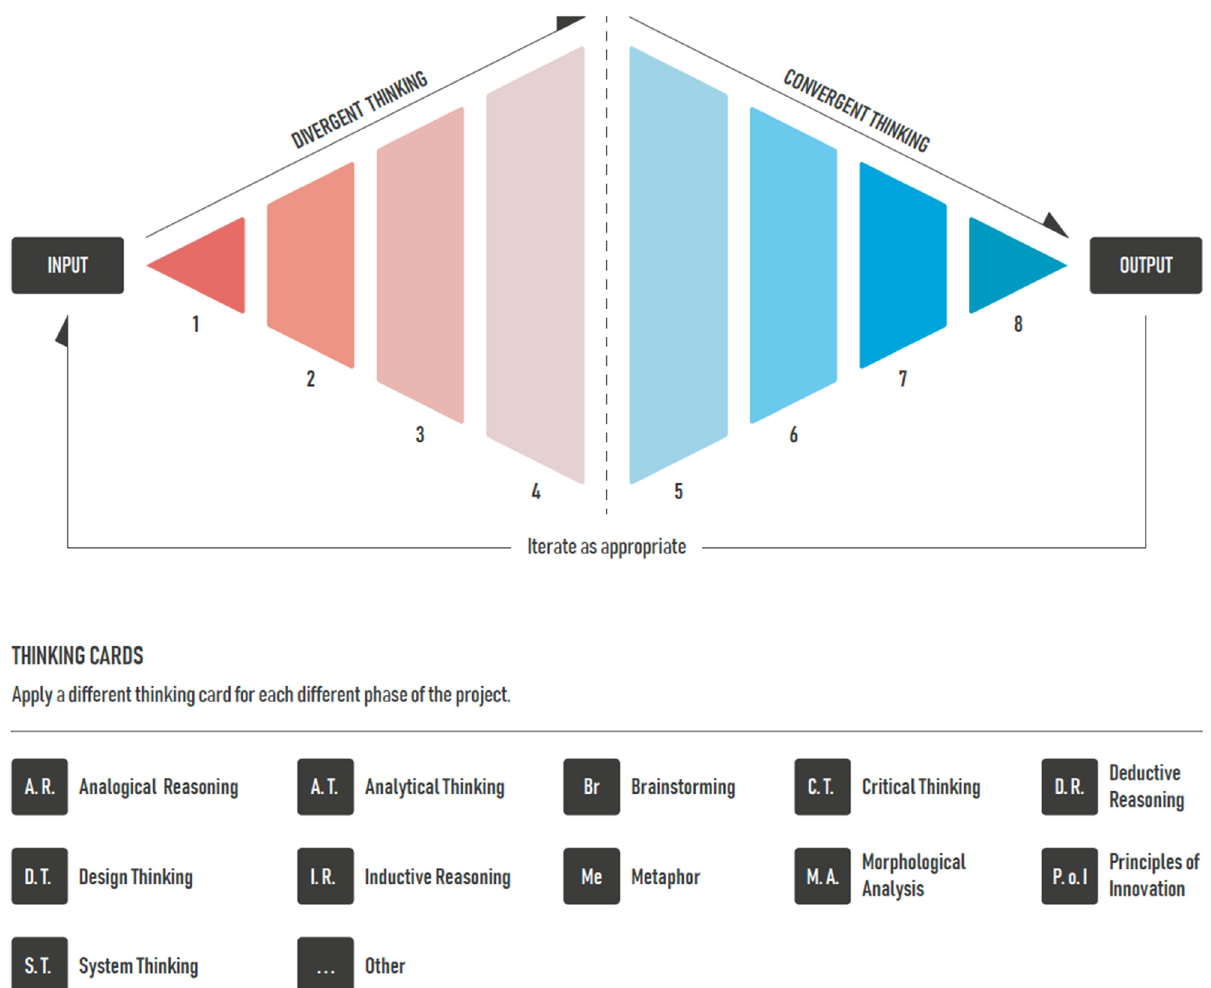
Figure 11. Creativity diamond graphic.